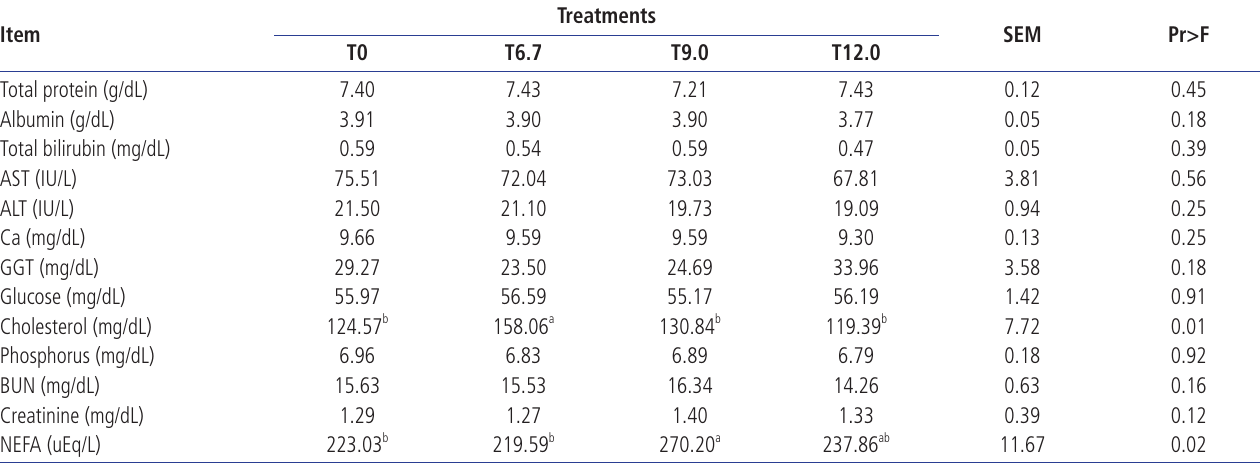
Table 3. Effects of dietary levels of tapioca residue on blood metabolites in late fattening Hanwoo steers